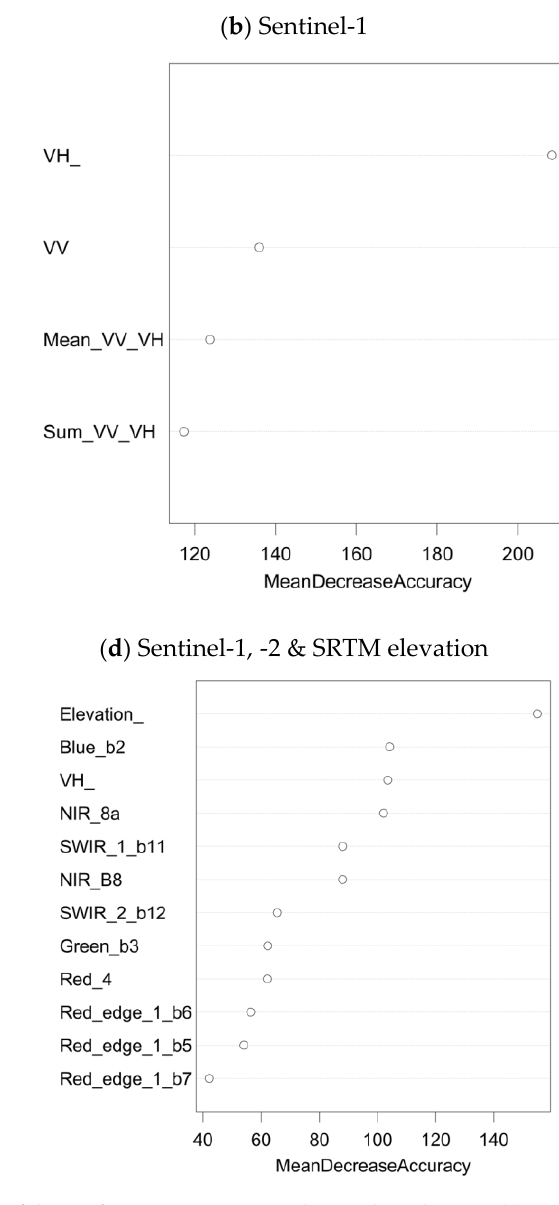
Figure 4. The important contribution of the RF feature importance selection-based MDA, ( a ) Scenario 1 (Sentinel-2 only), ( b ) Scenario 2 (Sentinel-1 only), ( c ) Scenario 3 (SRTM digital elevation model data only), ( d ) Scenario 4 (Sentinel-2 bands, Sentinel-1 (VH backscatter) and SRTM elevation